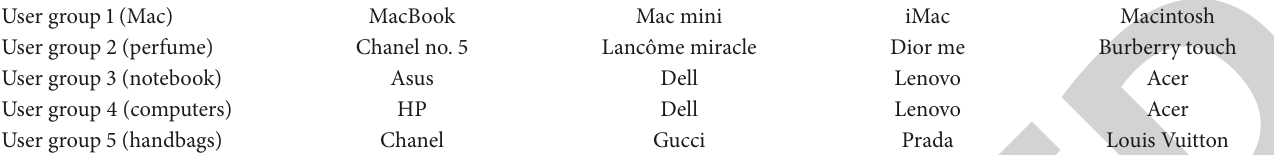
Table 5: The queries used for mining user group for evaluating our methods.